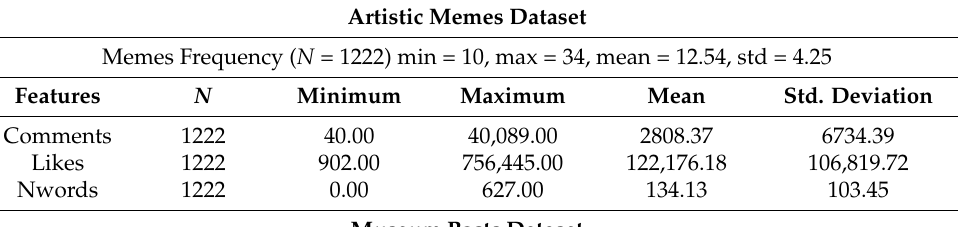
Table 1. Statistical description of Artistic memes dataset and Museum posts dataset. Artistic Memes